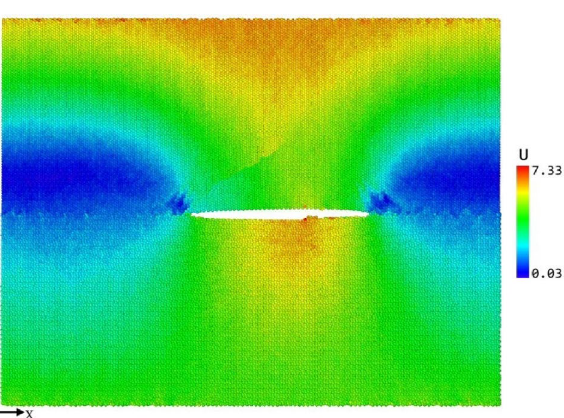
Figure 14. Cloud diagram of atomic displacement distribution at 60 ps of C–Fe terminal